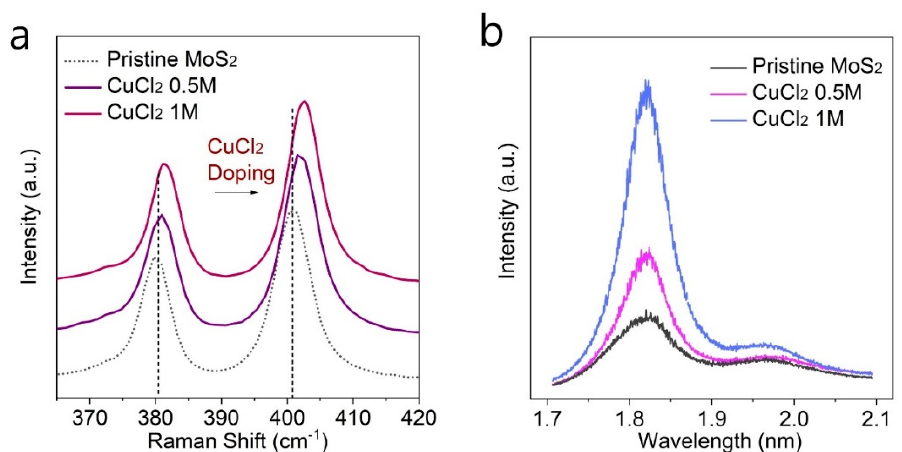
Figure 2. ( a ) Raman and ( b ) PL measurements before and after CuCl 2 doping. 0.5 M and 1 M CuCl 2 solutions were employed for doping. After CuCl 2 doping, the Raman spectrum of MoS 2 was blue-shifted and PL intensity was largely increased, showing p-type doping effect on MoS 2 .